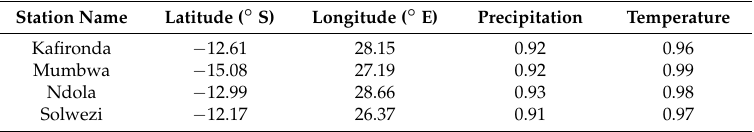
Table 1. Location of meteorological stations and Pearson correlation with regional